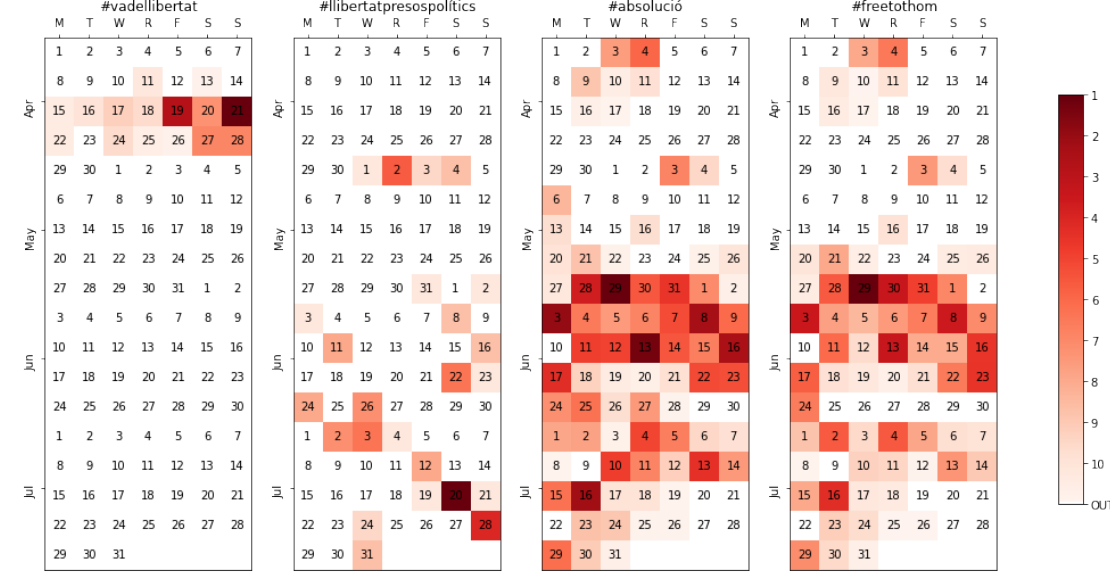
Figure 14. Calendar heatmap for #vadellibertat, #llibertatpresospolítics, #absolució, and #freetothom, all related to the Catalan nationalist